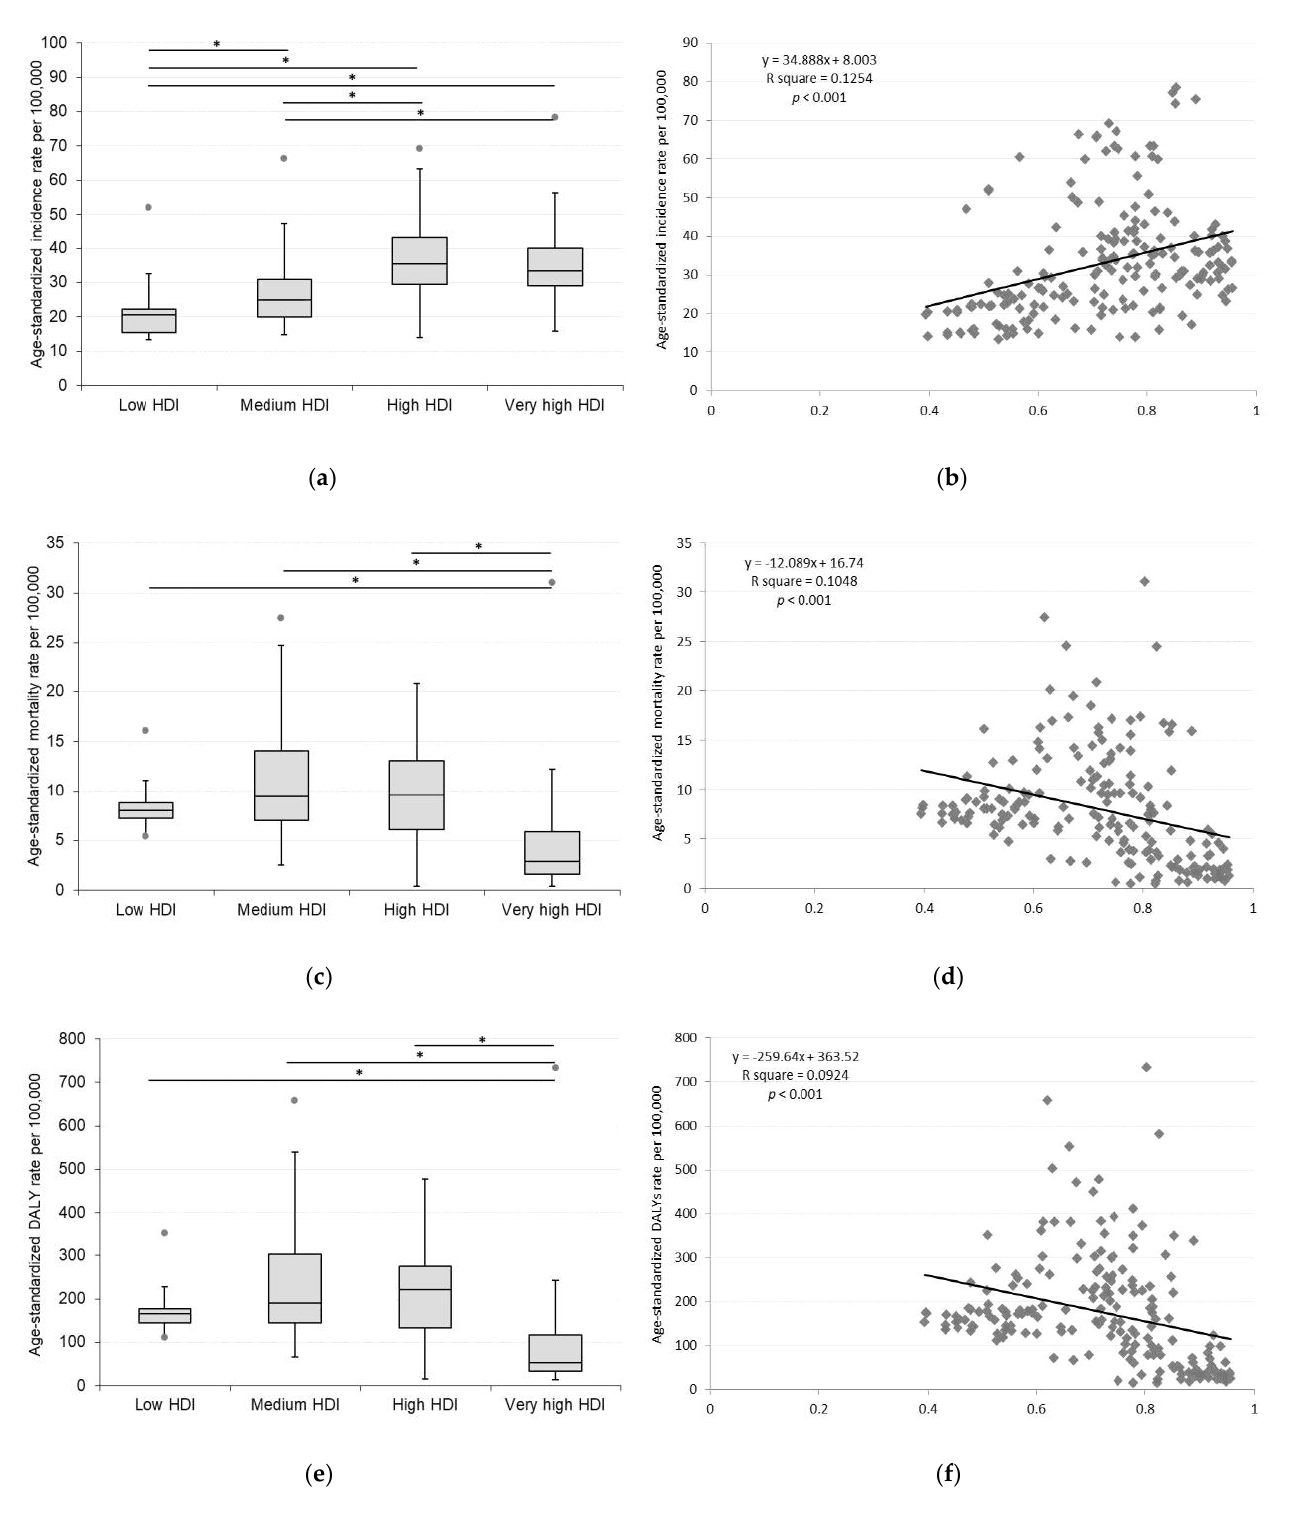
Figure 2. Association between socioeconomic development and ( a , b ) ASIR, ( c , d ) ASMR, and ( e , f ) age-standardized DALYs rate of CKD in 2019. * p < 0.05.